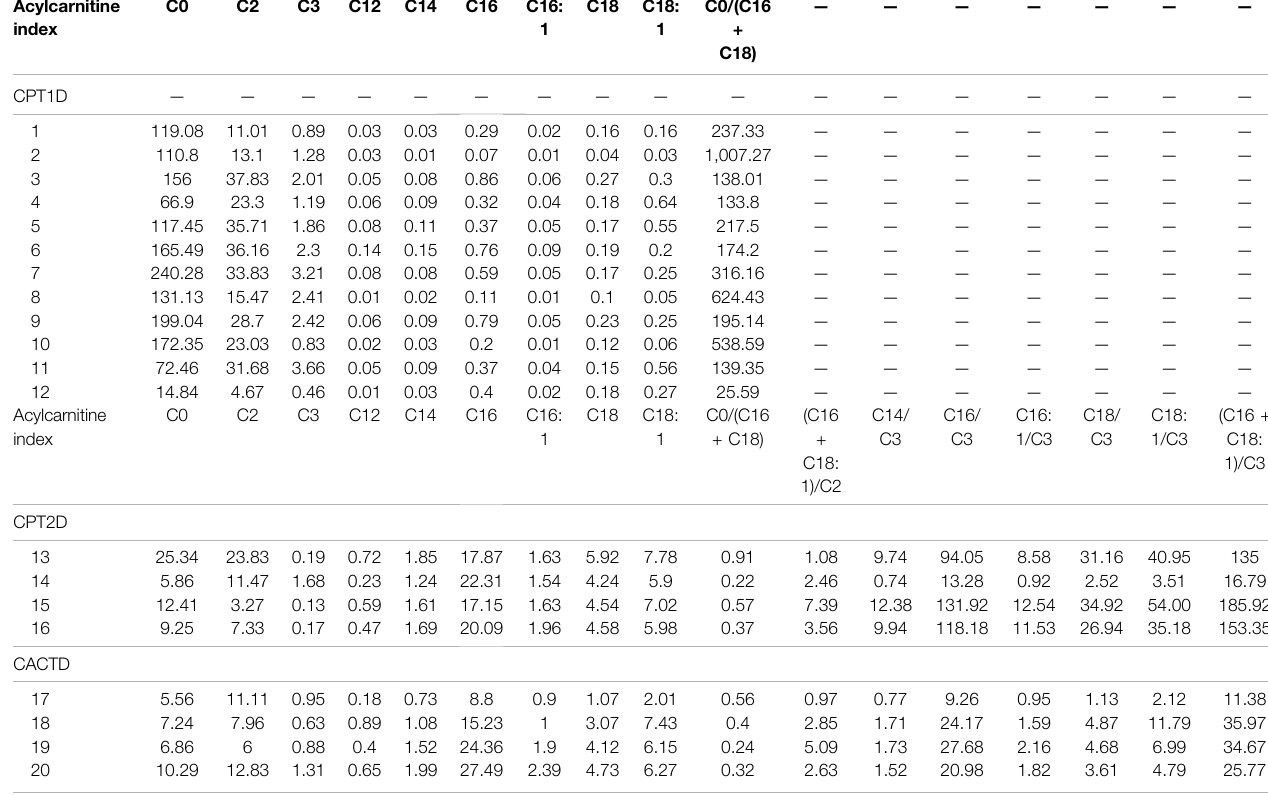
TABLE 1 | Initial screening results of acylcarnitine levels in Mitochondrial Carnitine-Acylcarnitine Cycle Disorders. Acylcarnitine